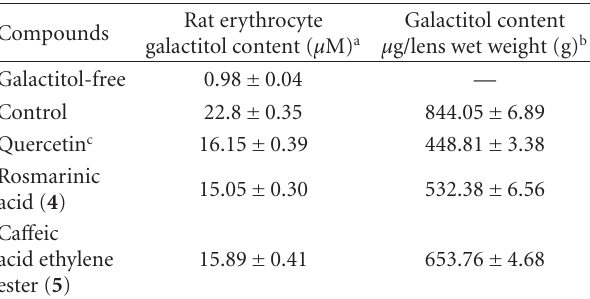
Table 3: Inhibitory e ff ect of the compounds on the galactitol accumulation in rat lenses and erythrocyte.